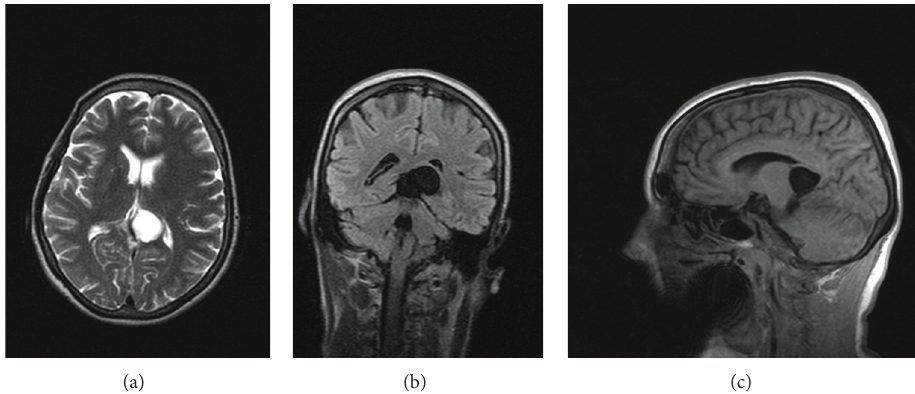
Figure 6: Cisterna ambiens arachnoidian cyst. (a) Round-ovalar, homogeneous, well-demarcated, hyperintense lesion with signal similar with CSF revealed by T2-weighted MRI image. (b) Round-ovalar, well-demarcated, hypointense cystic lesion with signal similar to CSF revealed by FLAIR MRI sequence. (c) Round-ovalar, homogeneous, well-demarcated, hypointense lesion with signal similar to CSF revealed by T1-weighted MRI image. Department of Neurology, Colentina Clinical Hospital brain imaging